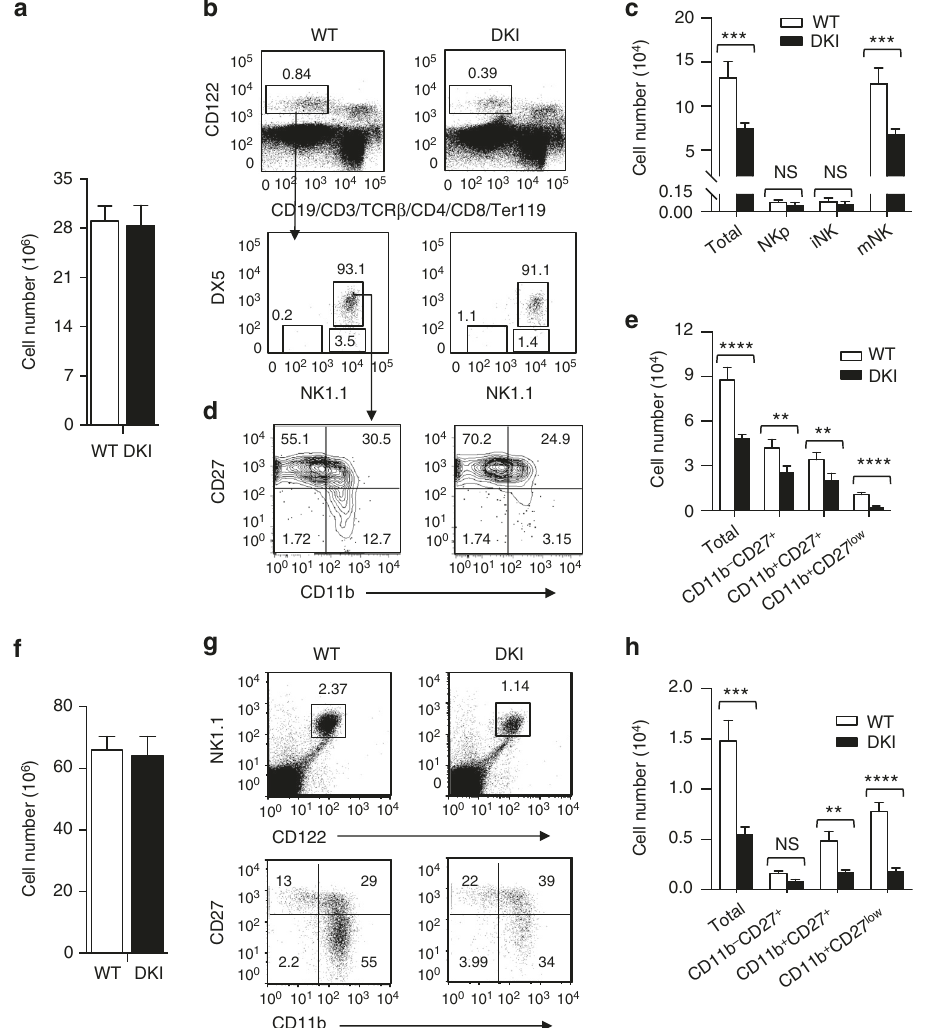
Fig. 1 Decreased bone marrow and splenic NK cells in Stat5 double knockin (DKI) mice. a Total bone marrow cell numbers from 8 WT (open bar) and 8 Stat5 DKI ( fi lled bar) mice after removal of red blood cells. b Representative fl ow cytometric data of total bone marrow NK cells (lin(CD19, CD3, TCR β , CD4, CD8, Ter119) − CD122 + ) (upper panels) and progenitor (NK1.1 − DX5 − ), immature (NK1.1 + DX5 − ), and mature (NK1.1 + DX5 + ) NK cells (lower panels) in WT and Stat5 DKI (DKI) bone marrow. The numbers are the percentage of gated populations. c Total bone marrow NK (Total), NK progenitor (NKp), immature NK (iNK) and mature NK (mNK) cell numbers from 8 WT (open bars) or 8 DKI ( fi lled bars) mice. d Representative fl ow cytometric data of total bone marrow NK cells from WT and Stat5 DKI mice gated as lin - CD122 + NK1.1 + DX5 + (lower panels of b ) and further characterised based on CD11b and CD27 staining. e Numbers of total bone marrow NK cells (Total) and CD11b − CD27 + , CD11b + CD27 + , and CD11 + CD27 low populations from 8 WT (open bars) and 8 Stat5 DKI ( fi lled bars) mice. f Total splenocyte numbers from 8 WT (open bar) and 8 Stat5 DKI ( fi lled bar) mice, after removing red blood cells. g Representative fl ow cytometric data of total splenic NK cells from WT and Stat5 DKI mice gated as CD3 − CD122 + NK1.1 + (upper panels) and further characterised based on CD11b and CD27 staining (lower panels). h Number of total splenic NK cells (Total), CD11b − CD27 + , CD11b + CD27 + , and CD11 + CD27 low populations from 8 WT (open bars) and 8 DKI ( fi lled bars) mice. Error bars in c , e and h are means ± SEM and statistical analyses were performed by grouped multiple t -test using Prism